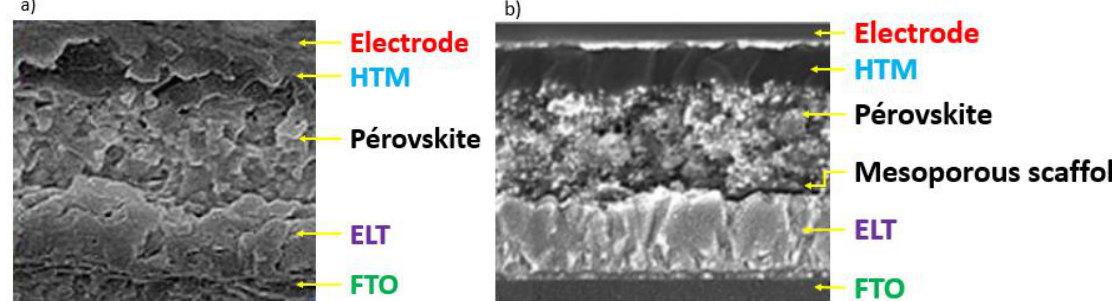
Figure 1 . The perovskite-based solar cell configuration: a) the planar configuration and b) the mesoporous configuration.